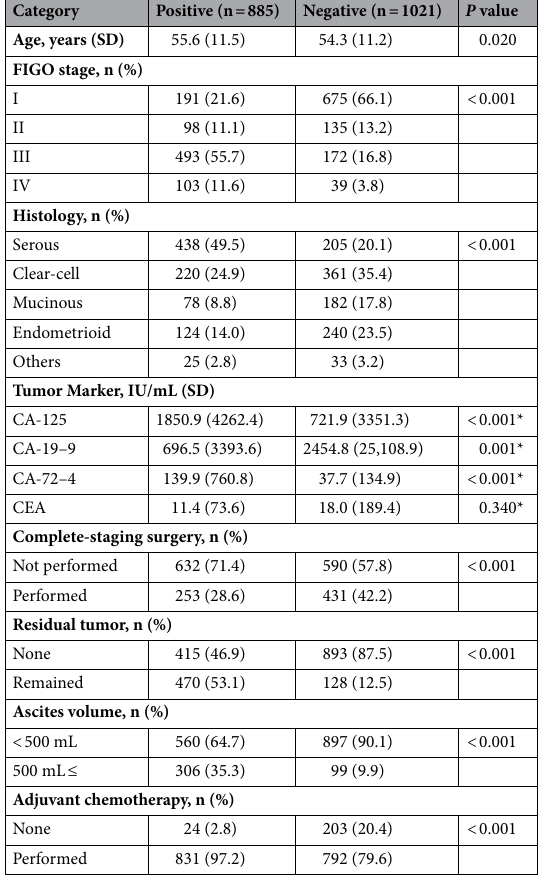
deviation, CA cancer antigen, CEA carcinoembryonic antigen. *Logarithmically transformed when